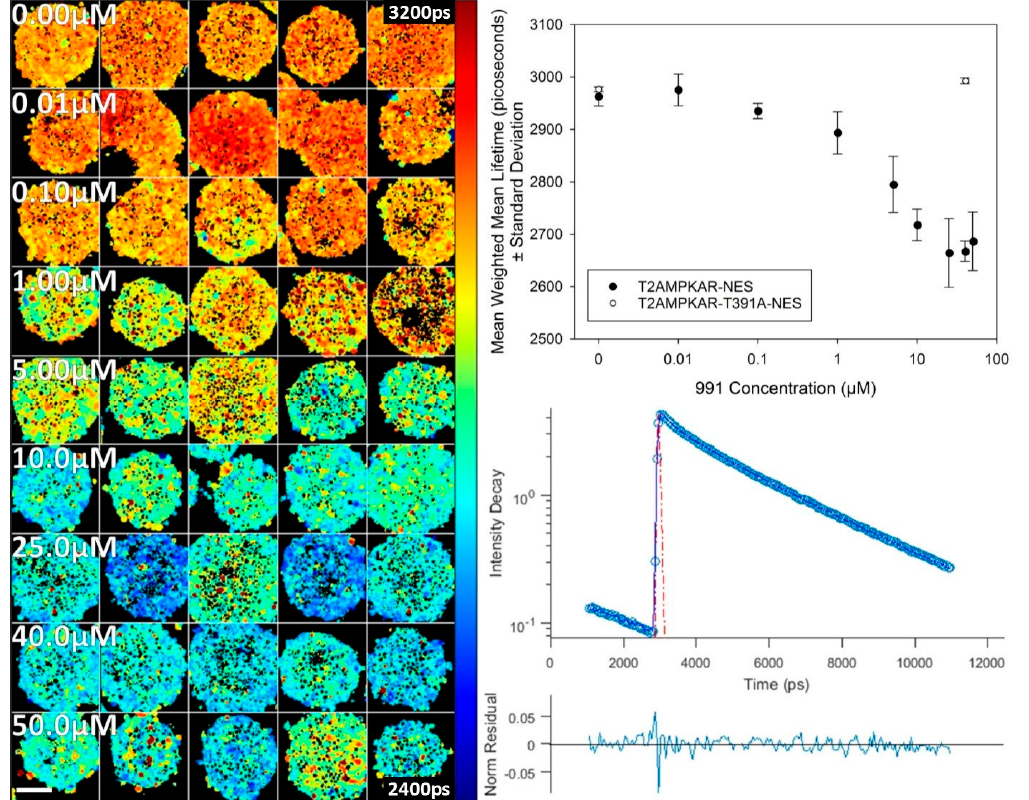
Figure 6. Titration of 991 in spheroids expressing T2AMPKAR-NES using TPE TCSPC FLIM. Left panel : FLIM map of weighted mean fluorescence lifetime with increasing concentrations of 991 (shown in panel). Upper right panel : plot of the mean weighted mean fluorescence lifetime dose response for 991. Comparison of spheroids expressing T2AMPKAR-T391A-NES is also shown; Lower right panel : exemplar fluorescence decay profile (blue circles) plotted with double exponential fitting (blue line), IRF (red dashed line) and residuals (lower). Lifetimes are shown in picoseconds (shown in image). Scale bar = 100 µm.